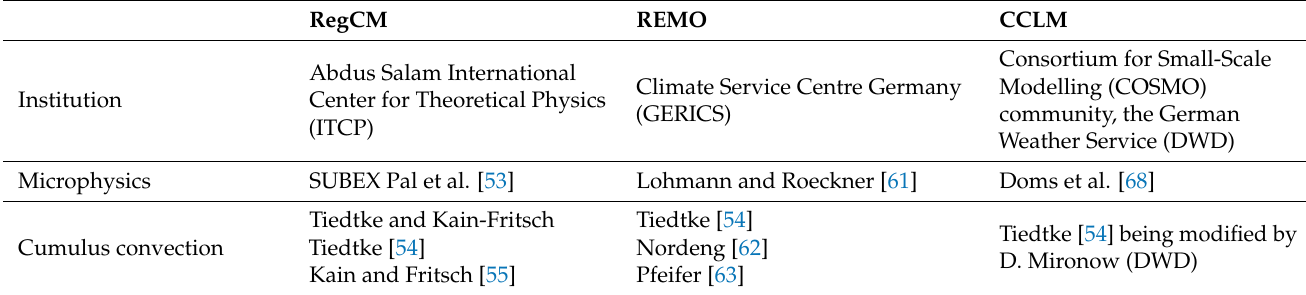
Table 1. Configuration of the RCMs used in this study in the CORDEX-CORE simulation